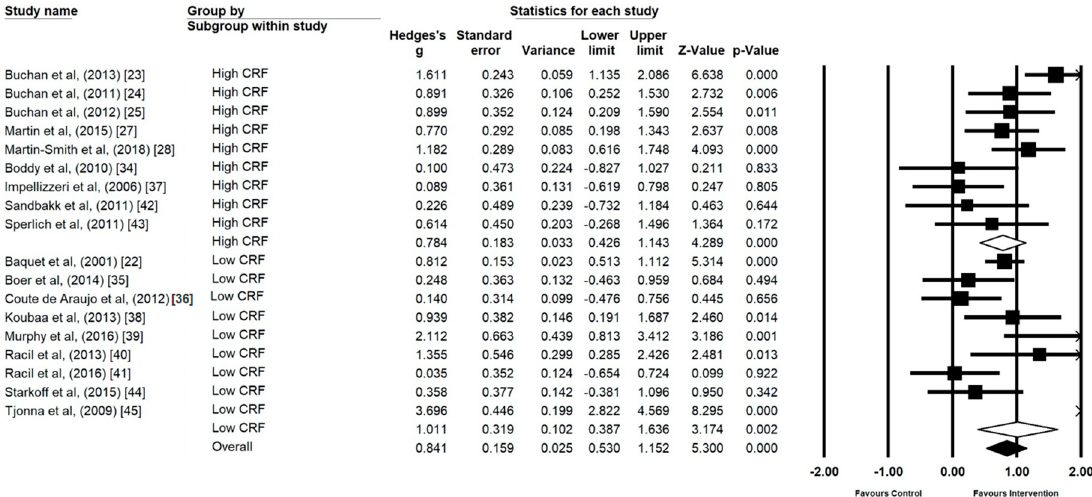
Figure 6. Forrest Plot of the Comparison of effect size of high intensity interval training (HIIT) and sprint interval training (SIT) on cardiorespiratory fitness (CRF) in studies using CRF levels at baseline.